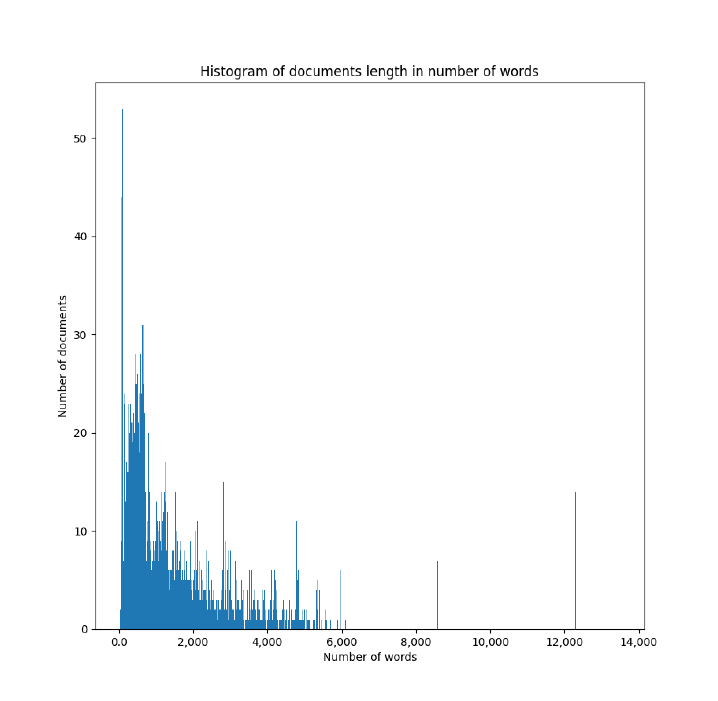
Figure 13. Distribution of words frequency in